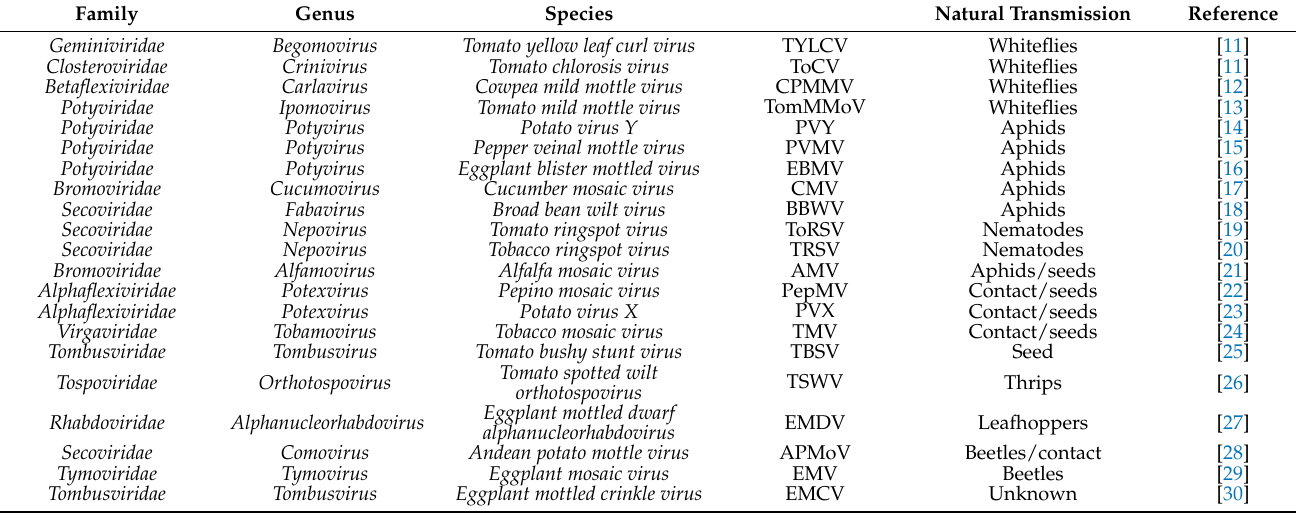
Table 1. List of viruses naturally infecting eggplant plants and their natural transmission modes. Family Genus Species Natural Transmission